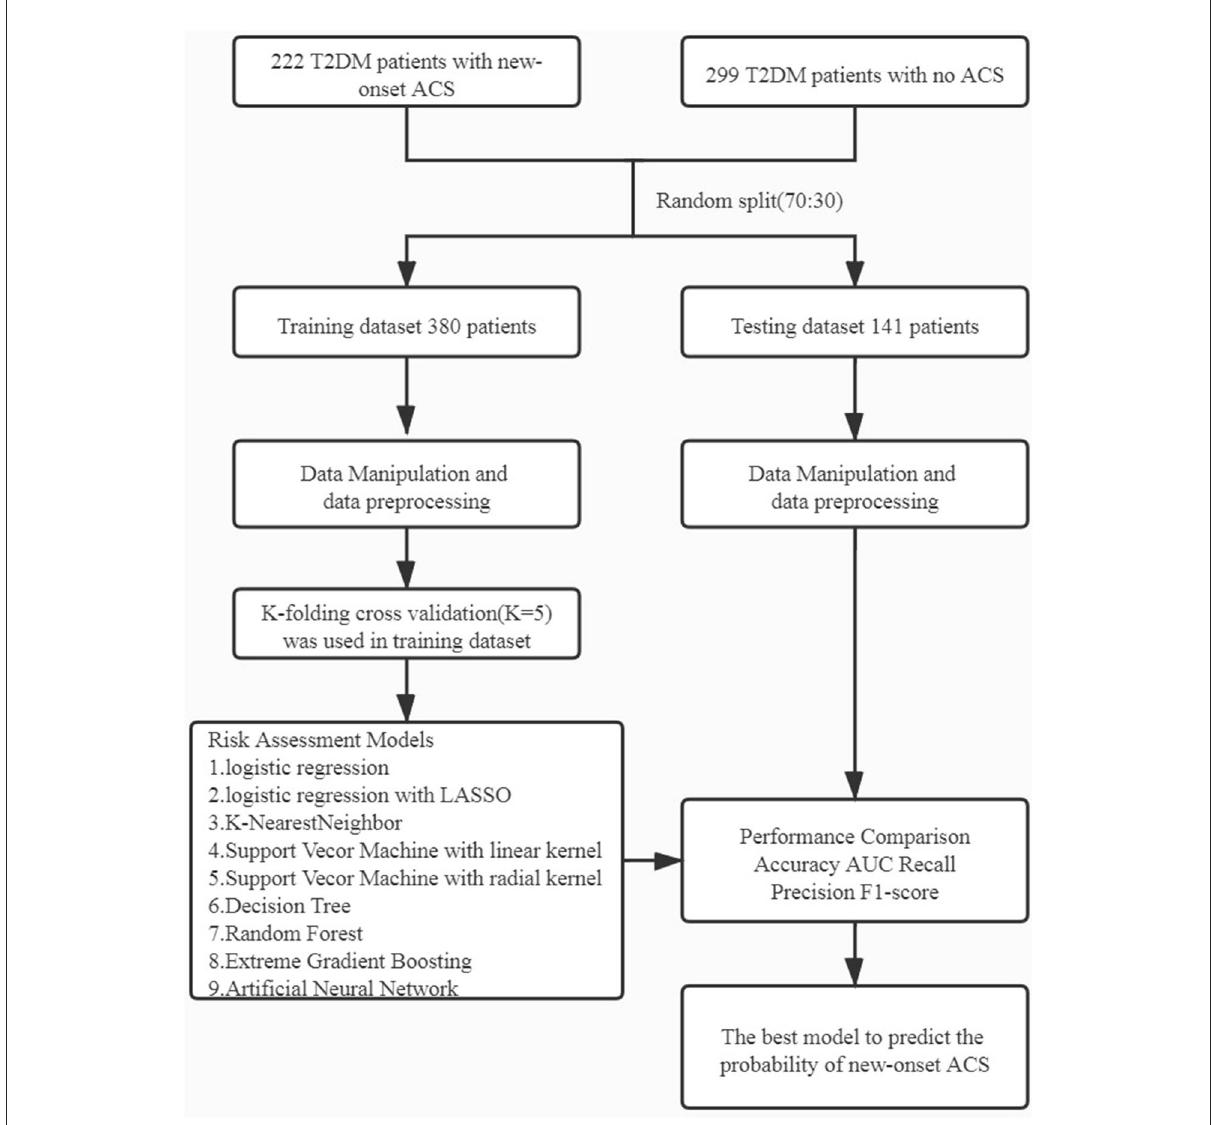
FIGURE1 Workflow diagram: The initial dataset was randomly split into training dataset and testing dataset in the ratio of 70:30. Different machine learning algorithms were using k-folding cross validation (k = 5). ACS, acute coronary syndrome.